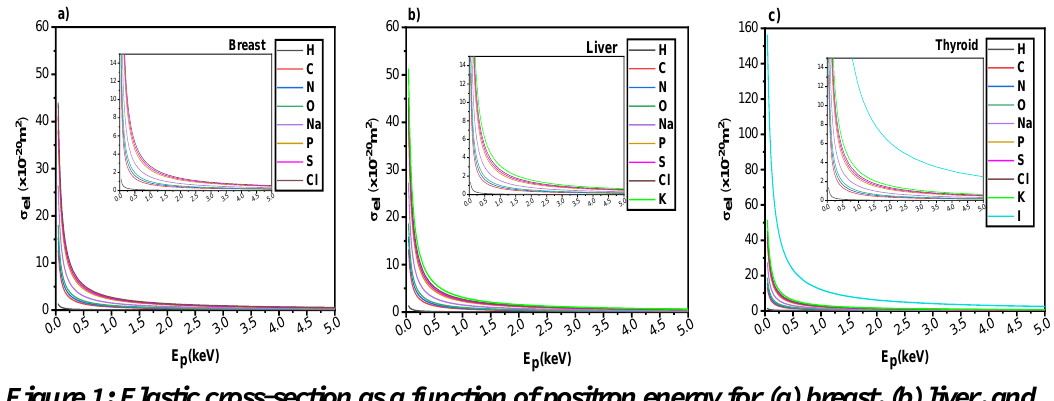
Figure 1: Elastic cross-section as a function of positron energy for (a) breast, (b) liver, and (c)